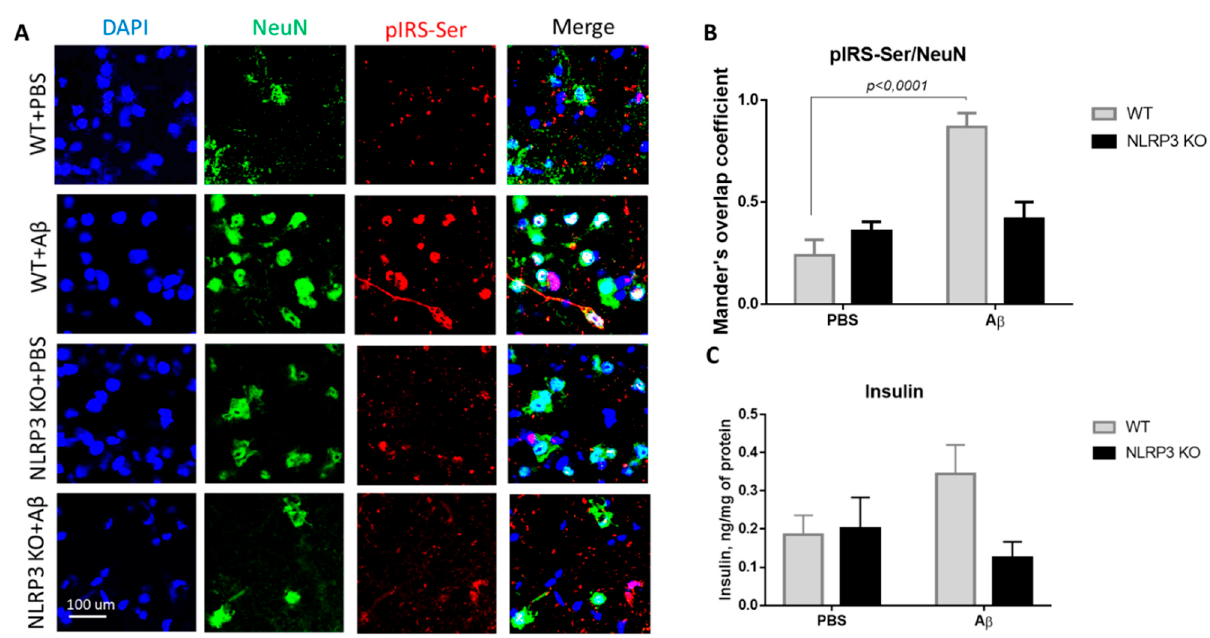
Figure 5. Results of insulin and serine phosphorylated insulin receptor substrate (pIRS-Ser) measurements. ( A ) Representative confocal images of pIRS-Ser-expressing neurons and stained for DAPI (blue), NeuN (green), pIRS-Ser (red), signal overlay (merge). Scale Bar 100 µ m. ( B ) The Mander’s overlap coefficient in pIRS-Ser+ and NeuN+ double labeling cells. Data are presented as means ± SEM, two-way ANOVA. ( C ) Insulin measurement in homogenates of the amygdala (ng/mg of protein). WT—wild type control mice, NLRP3 KO—NLRP3 knockout mice, A β —amyloid beta injection, PBS—phosphate buffered saline injection (sham operation).